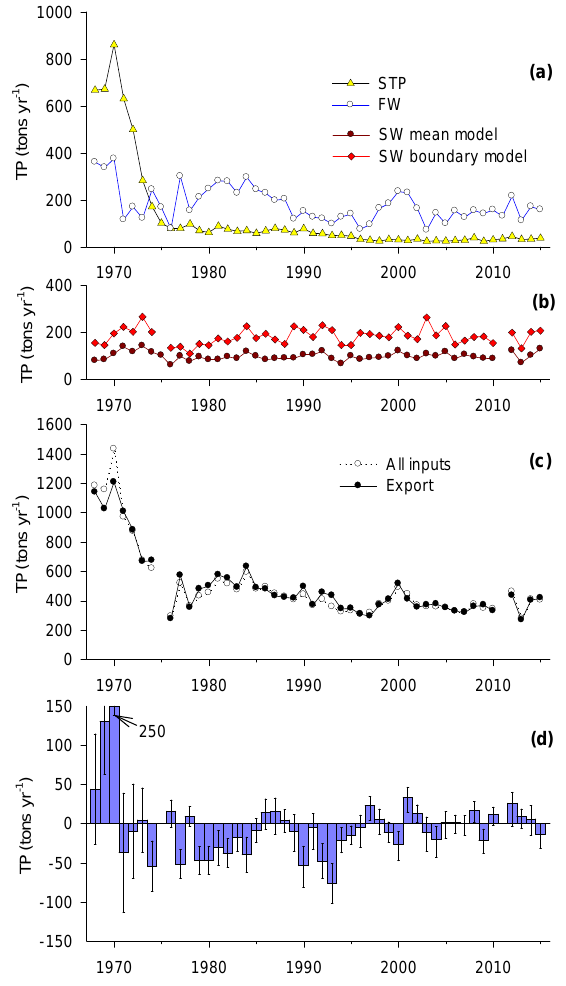
Figure 5. Annual total phosphorus (TP) inputs, TP export, and net TP balance. (a) Annual TP load from sewage treatment plants (STPs), from freshwater runoff from Lake Mälaren plus the lo- cal catchment (FW), and (b) from modelled inflow of middle archipelago deep water (SW), calculated with boundary and mean models (see methods). (c) Total annual external TP input and ex- port, using the boundary model. (d) Net input–export according to the boundary model (difference of values in c ) with error bars show- ing maximums and minimums from the sensitivity test. Positive val- ues indicate that the inner archipelago accumulates P and negative values that it is a net source of